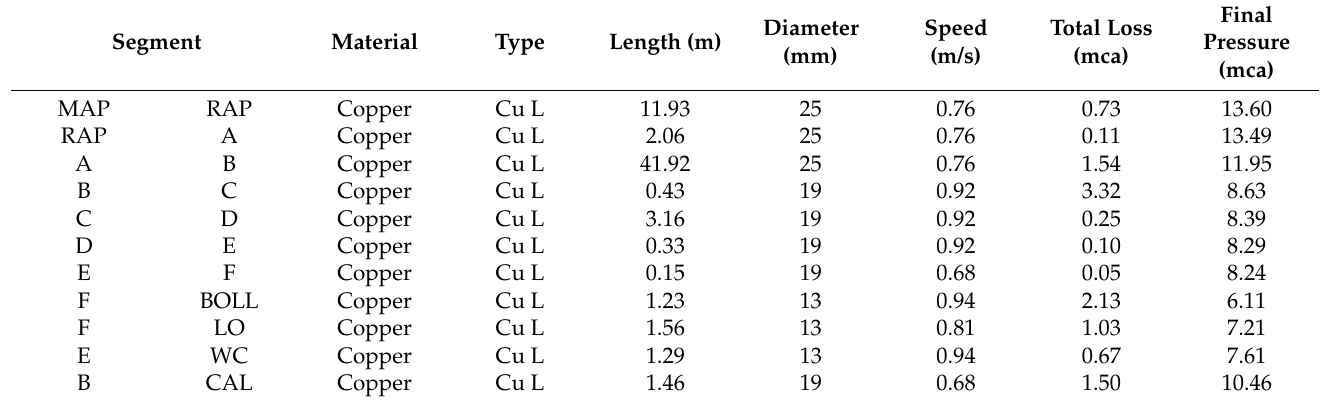
Table 20. Losses in the cold potable water system for type 2 retail store.